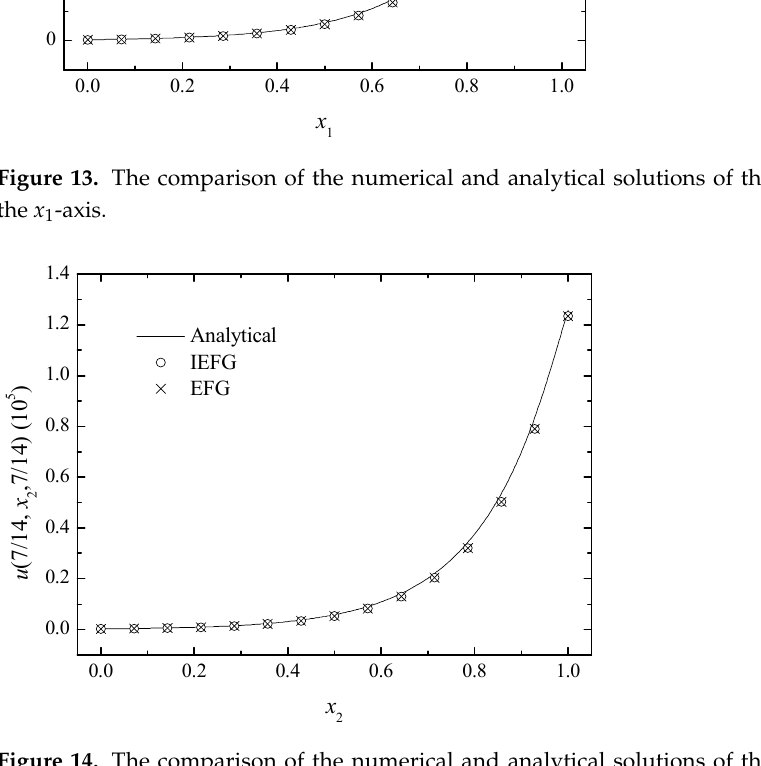
Figure 14. The comparison of the numerical and analytical solutions of the two methods along the x 2 -axis.